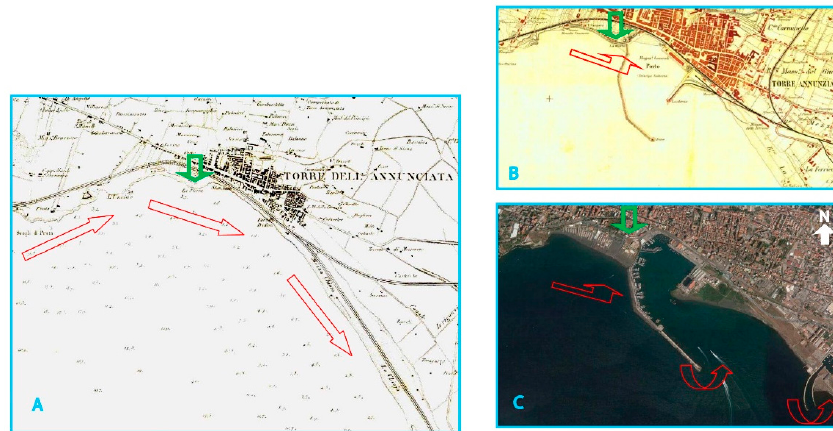
Figure 5. Torre Annunziata coastal area morphoevolution from 1865 to 2018. ( A ) 1865 map: the harbor of Torre Annunziata was not shown on maps yet. The red arrows indicate the direction of longshore currents; the green arrow indicates a promontory called La Storta; ( B ) a historical IGM map from 1906 shows the Torre Annunziata harbor for the first time. Gradually, the sediments carried by NW-SE longshore currents became trapped. A new narrow beach is evident to the NW of the artificial harbor; ( C ) 2018: a wide triangular-shaped beach on the updrift side (NW) of the breakwall of the Torre Annunziata harbor. The red curved arrows indicate the effect of the wave diffraction processes around both the outer breakwaters of the Torre Annunziata harbor and the outer jetty of the Apreamare boatyard. These processes have led to the gradual growth of new triangular-shaped beaches in down drift sides.